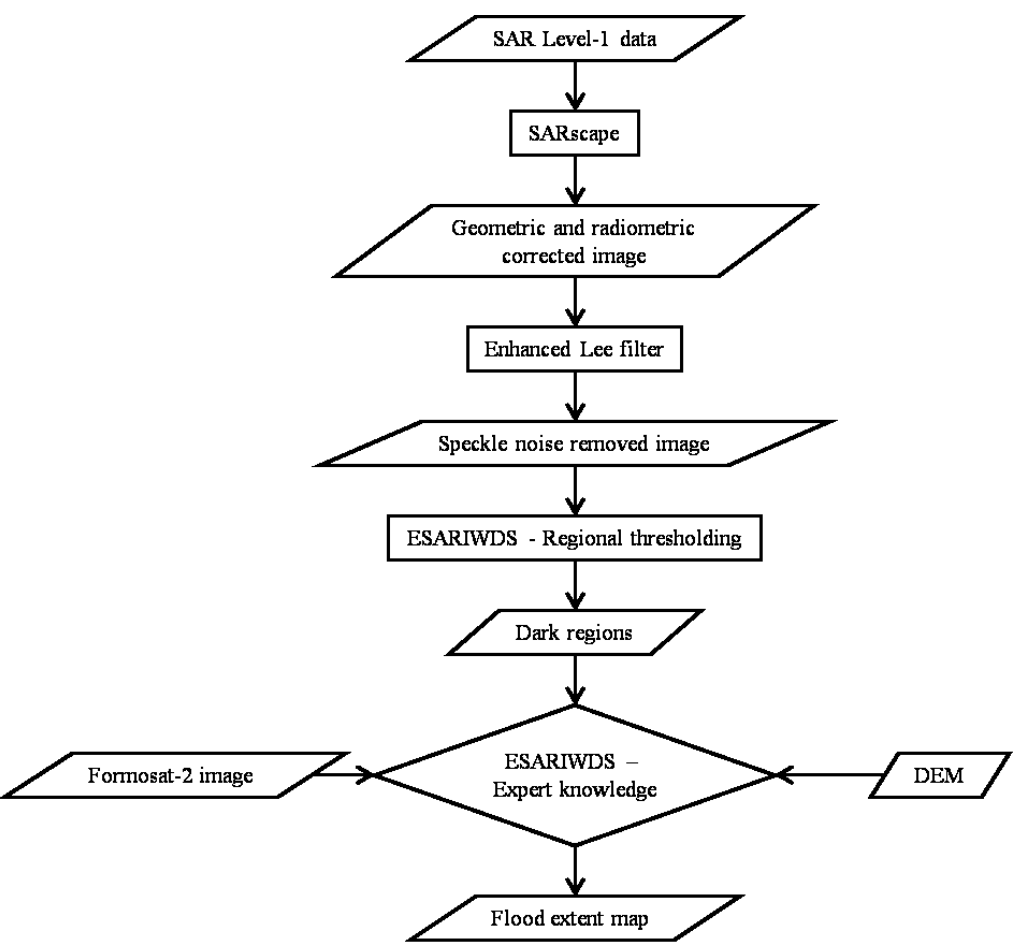
Figure 4. The flowchart of flood extent detection using the Expert Synthetic Aperture Radar Imagery Waterbody Delineation System